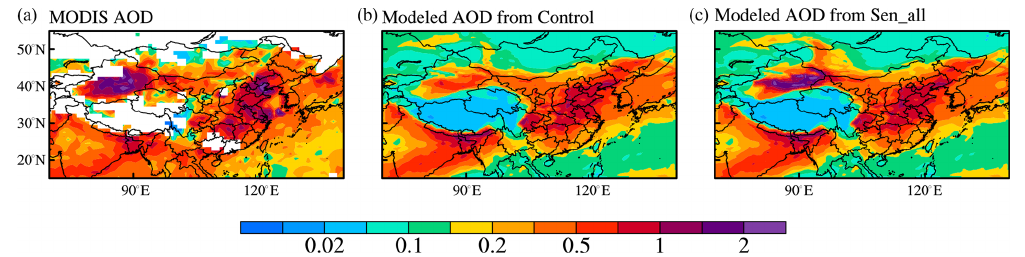
Figure 12. Spatial distribution of MODIS-retrieved AOD at 550nm (a) and simulated AOD at 550nm from the control run (b) and from Sen_all (c) . The simulation results are extracted at 13:00 local time to match the MODIS observation